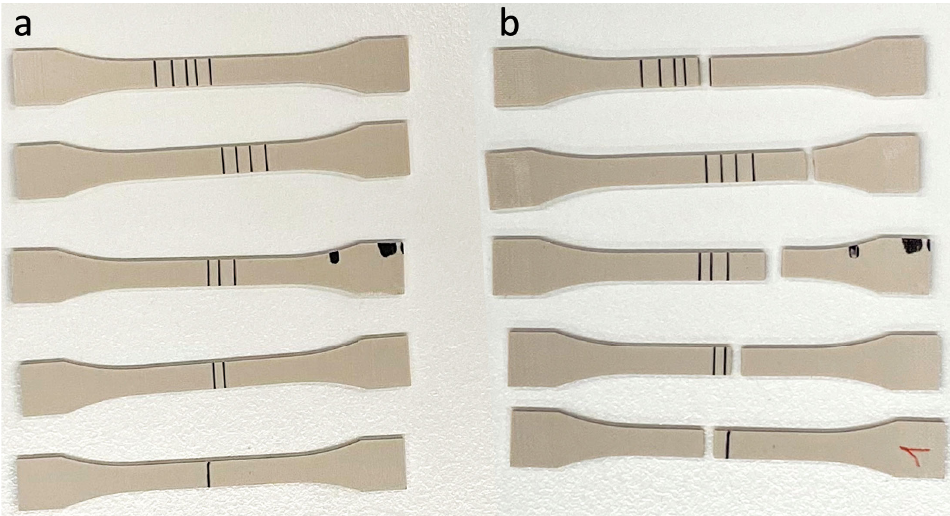
Figure 6. ( a ) The 3D ‐ printed samples of subgroup 3.1; ( b ) fractured samples after tensile test.